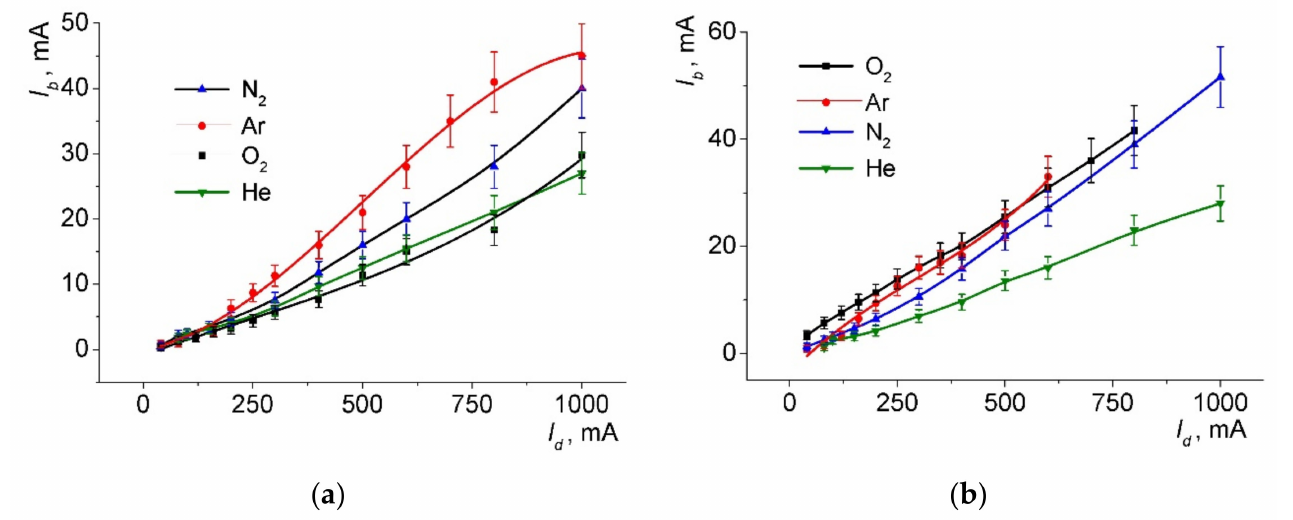
Figure 5. Beam current versus accelerating voltage for different discharge currents I d . Oxygen pressure is 2.6 Pa.